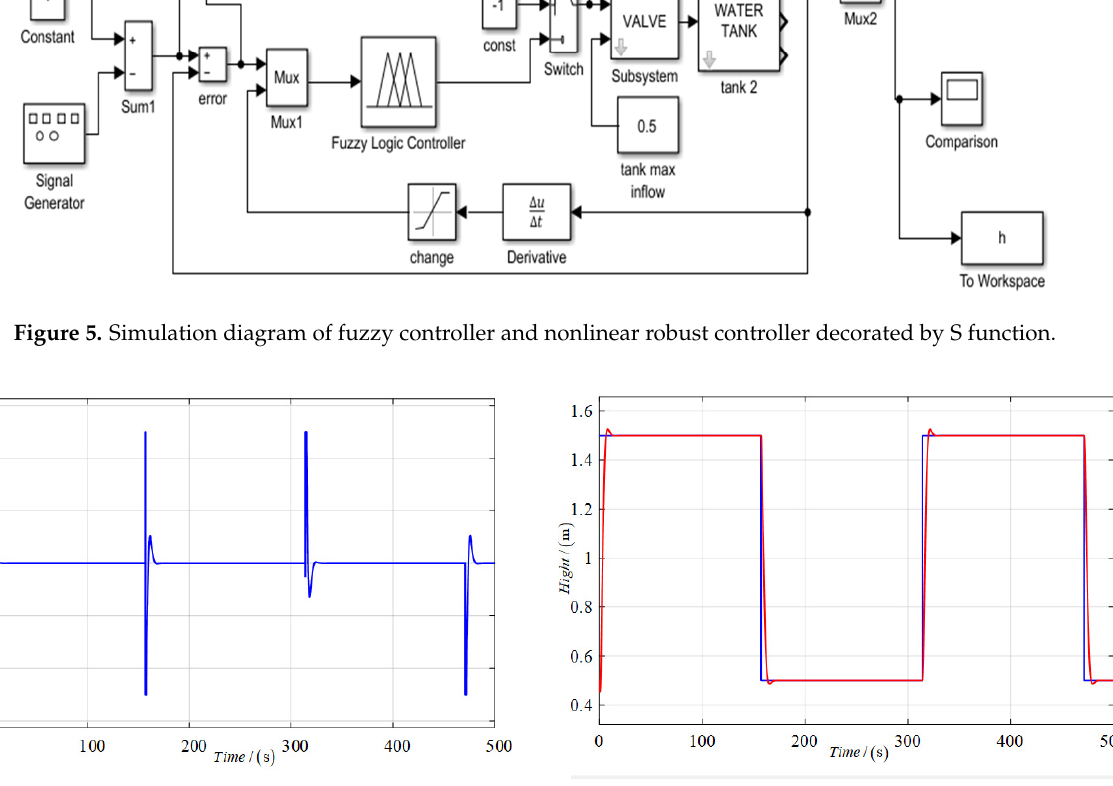
Figure 5. Simulation diagram of fuzzy controller and nonlinear robust controller decorated by S function.